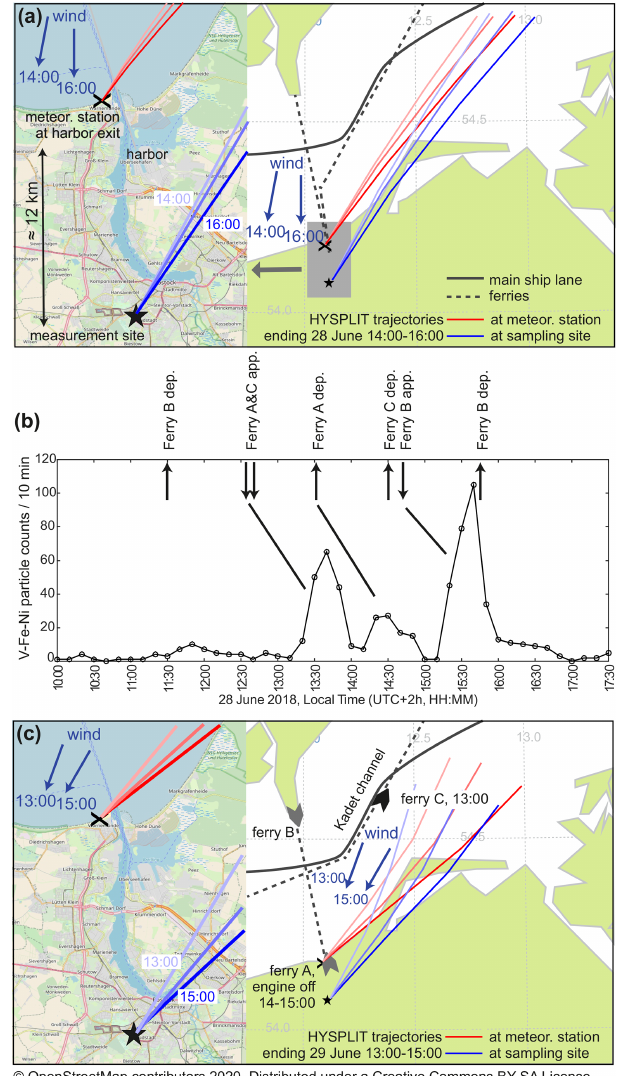
Figure 6. Assignment of transient particle events to distant ship passages. (a) For the first transients, observed on 28 June during a period of northern wind, the HYSPLIT trajectories indicate transport of particles from distant sea areas to the sampling site (star). However, the measured wind directions (blue arrows) in conjunction with ship transponder data reveal ferries with scrubbers as the probable source. (b) Time series of particles from the transient group during northern winds on 28 June. The particle events follow the approach and departure times of the ferries (arrows) with a delay of about 45min during optimum wind directions. (c) On 29 June, the wind direction is north- northeast, and only one weak transient event appears (see Fig. 4). However, a broader feature of aged V–Fe–Ni particles at 15:00 indicates a distant source, and ferry C is underway in the Kadet channel in the respective time frame (and six further ships). The difference between trajectories and measured wind data emphasizes the importance of accurate meteorological data in potential future monitoring